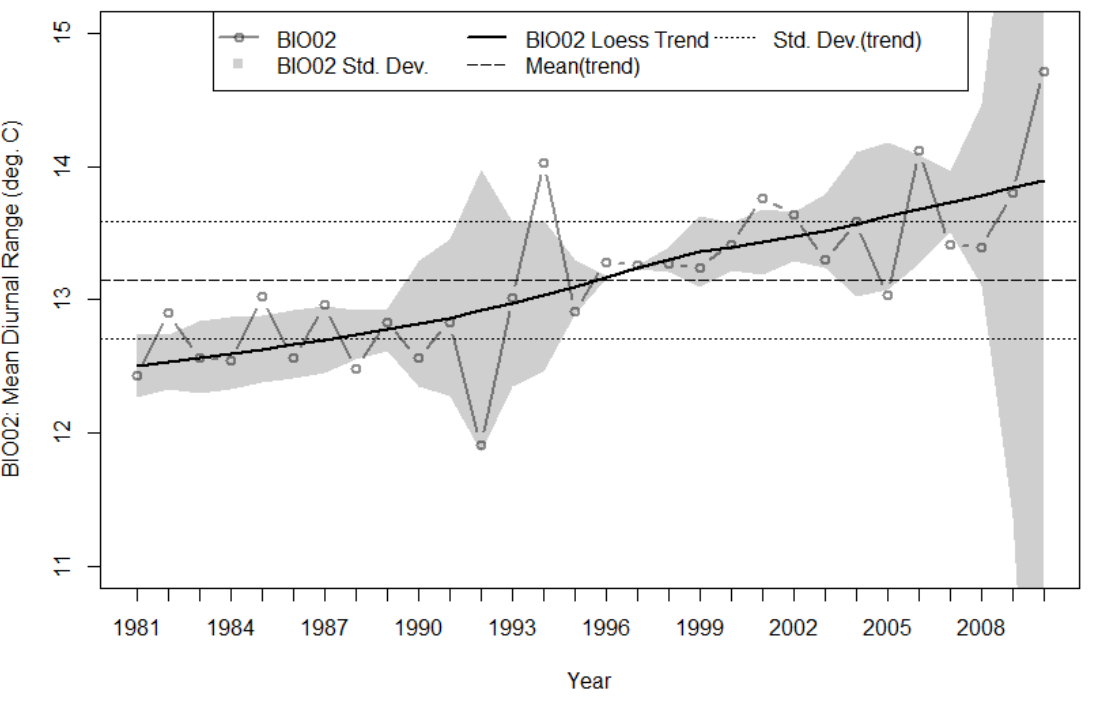
Figure 9. BIO02 is the ‘Mean Diurnal Range’, the mean of the difference of the monthly maximum and minimum temperature [53], for the period 1981–2010. Derived from the AWAP [39] using Hijmans et al . [54].